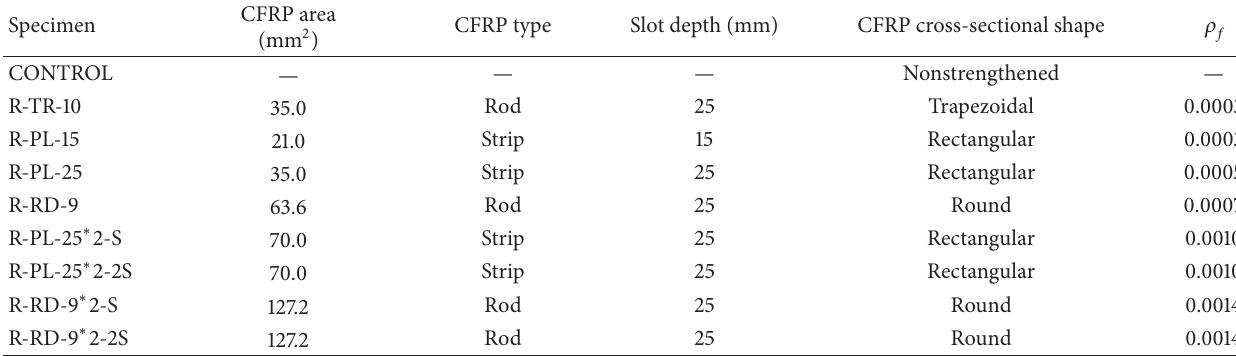
Table 1: Designation of specimens and corresponding test